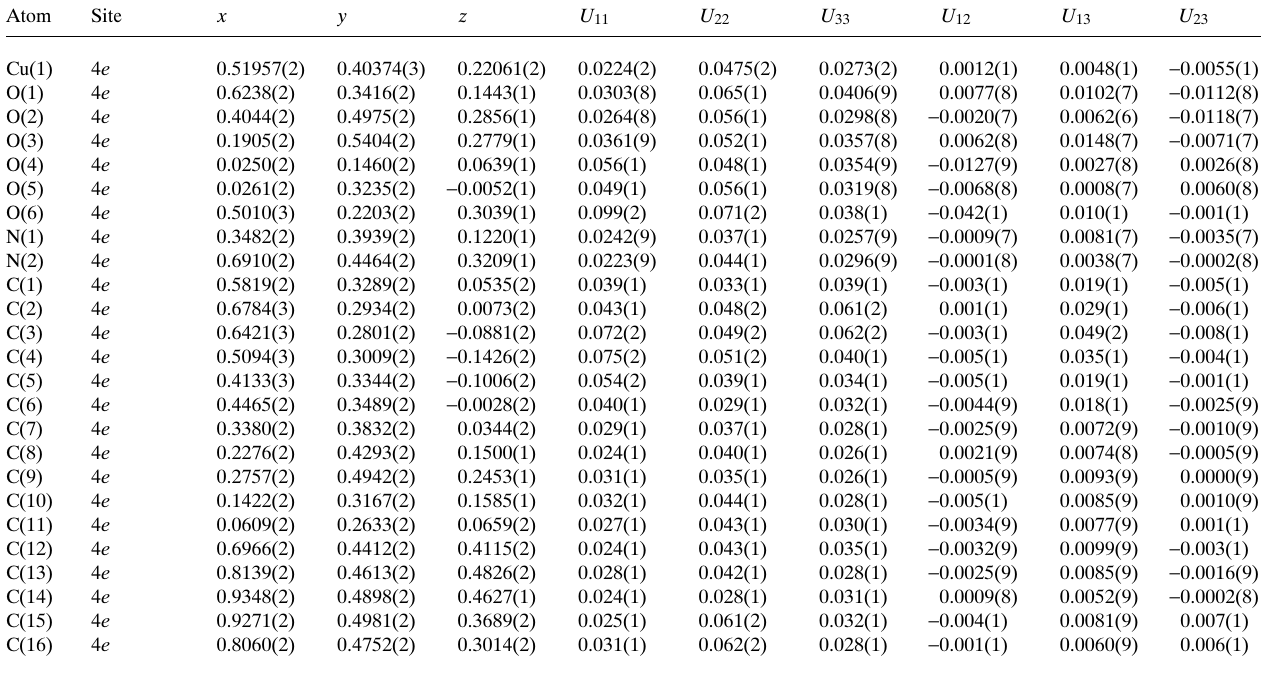
Table 3. Atomic coordinates and displacement parameters (in Å 2 ) .